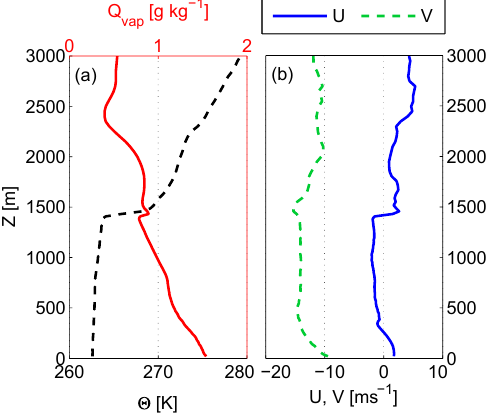
Figure 1. Profiles of potential temperature ( (cid:50) ), water vapour mix- ing ratio ( Q vap ), and wind speed ( U , V ) used to initialise the LEM.